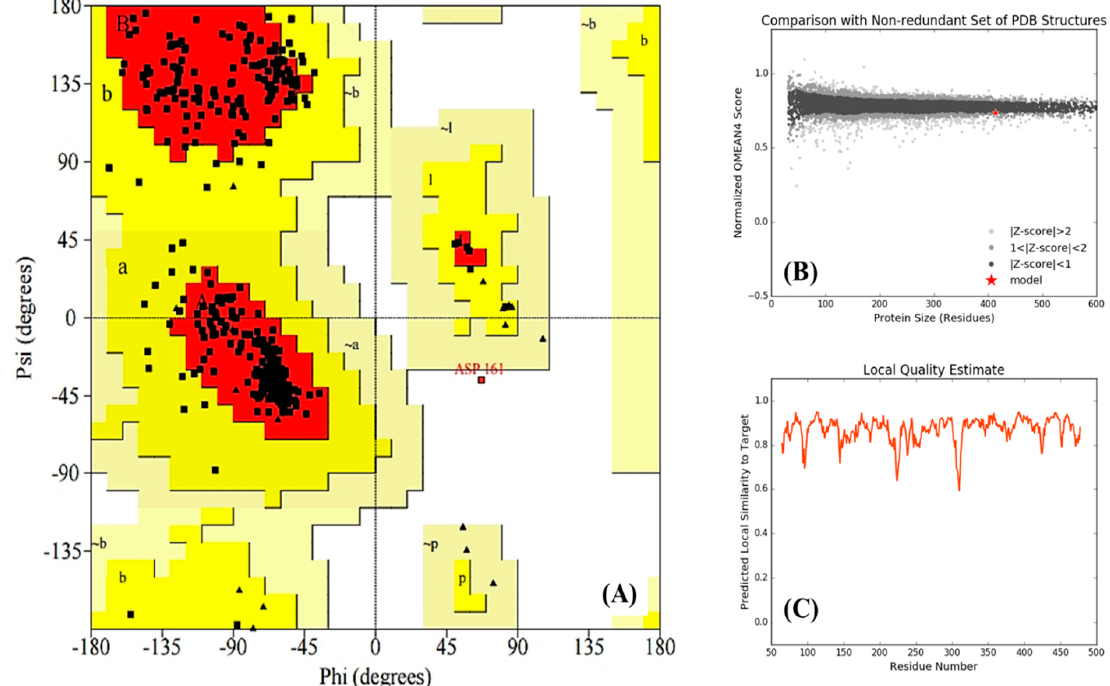
Figure 4. Validation of the generated homology model of Fophy. ( A ) Ramachandran plot, ( B ) comparison plot, and ( C ) local quality plot. For more information about Ramachandran plot descriptions the reader should be referred to the web site at ( https://www.ebi.ac.uk/thornton-srv/databases/cgi-bin/pdbsum/GetPage.pl?doc=TRUE&pdbcode=n/a&template=doc_procheck01.html ).